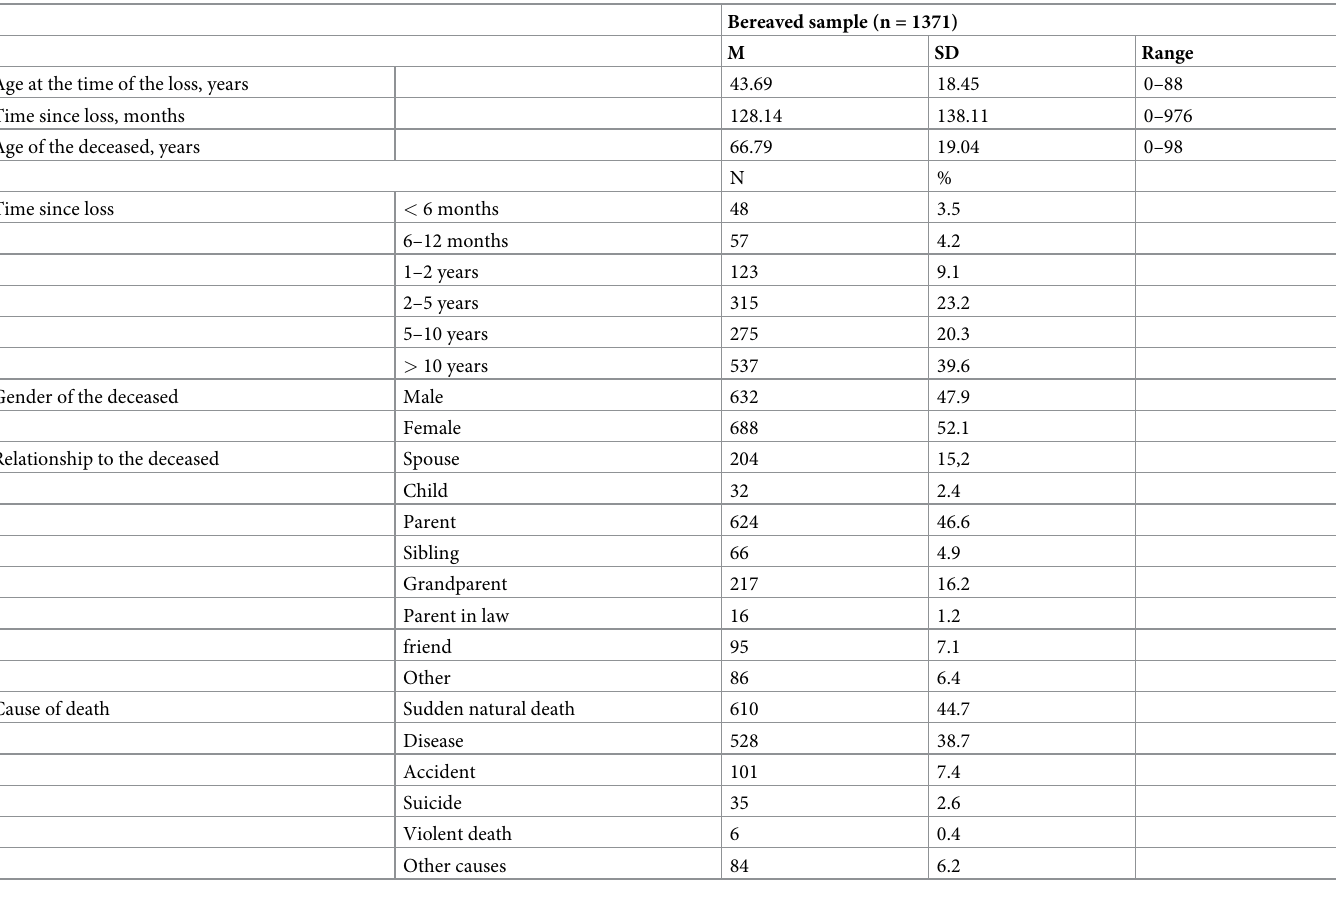
Table 2. Loss-related characteristics of the bereaved sample.